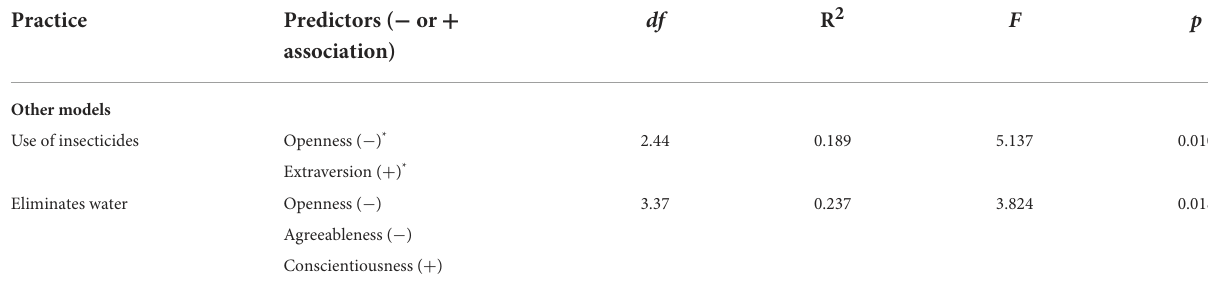
TABLE 8 Multiple regressions for personalities predicting